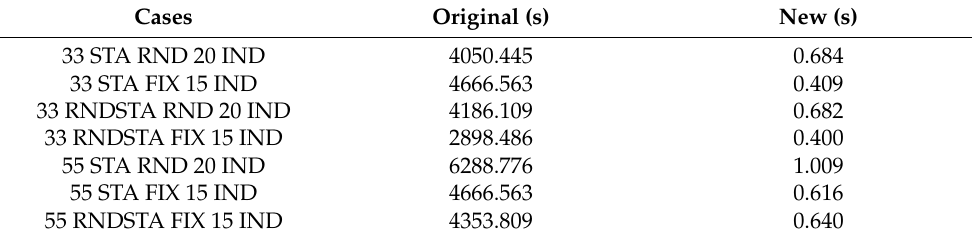
Table 3. Comparison for the computational time (s) between the original and the new fitness